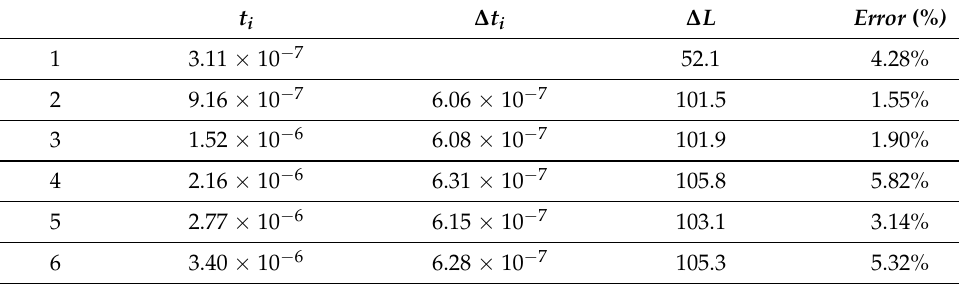
Table 3. Distance calculations from the signal derivatives and respective location